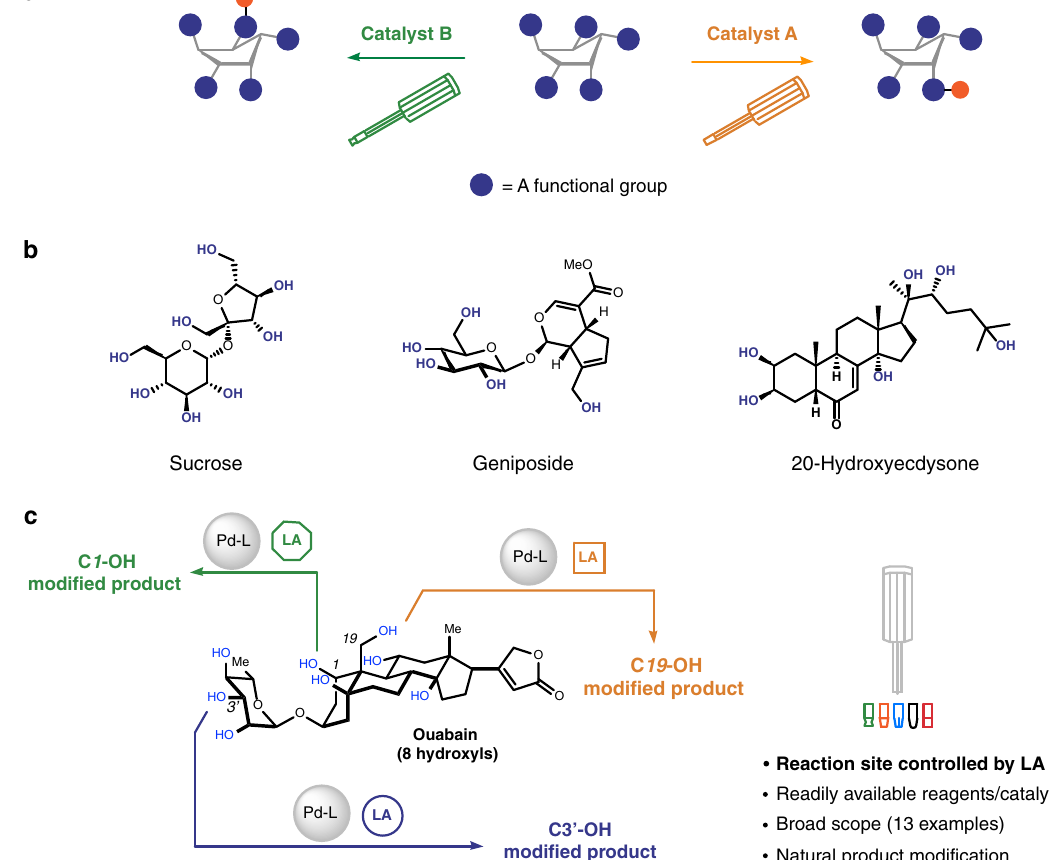
Fig. 1 Site-switchable modi fi cation of molecules containing multiple identical functional groups. a Reagent/catalyst-controlled, site-selective modi fi cation of complex molecules: a challenge in synthetic chemistry. b Some representative, naturally occurring polyols. c Pd/Lewis acid co-catalyzed, site-switchable modi fi cation of polyols (this